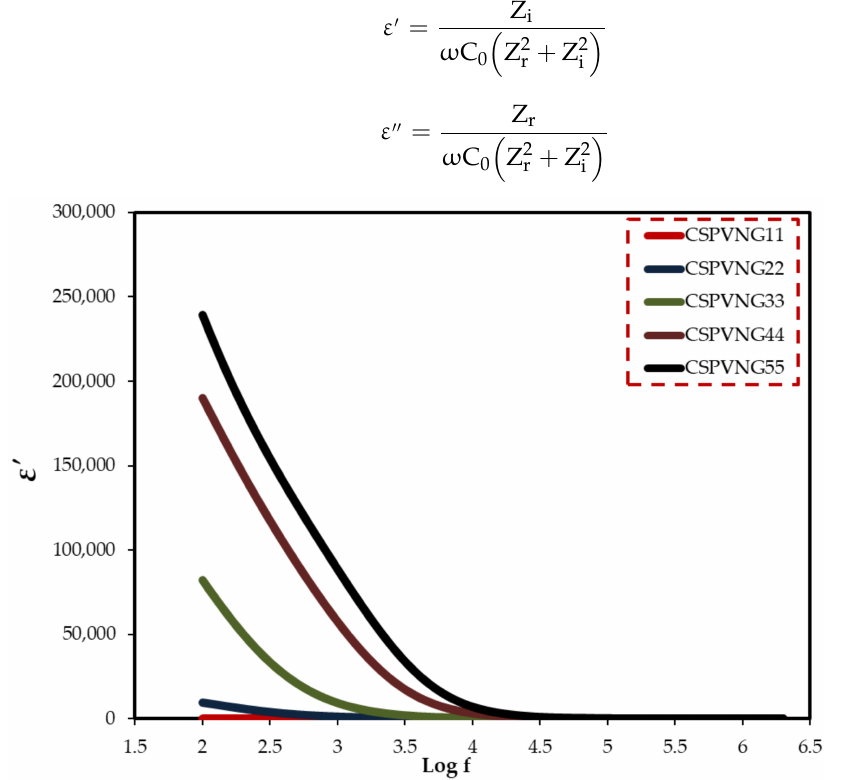
Figure 9. Dielectric constant versus log(f) for the electrolyte samples. The vacuum capacitance, C o , is provided by the formula ε o A/t, where ε o is the free space permittivity, which is to 8.85 × 10 − 12 F/m. If f is the applied field frequency, the angular frequency ( ω ) is equal to 2 π f